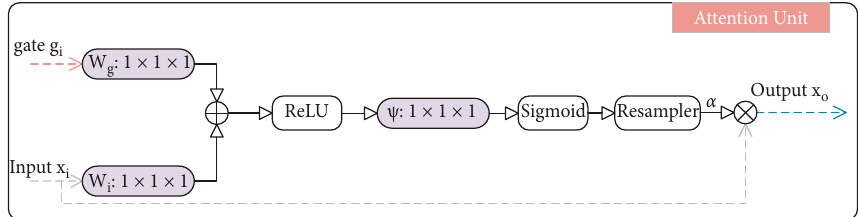
Figure 5: Schematic diagram of attention unit.